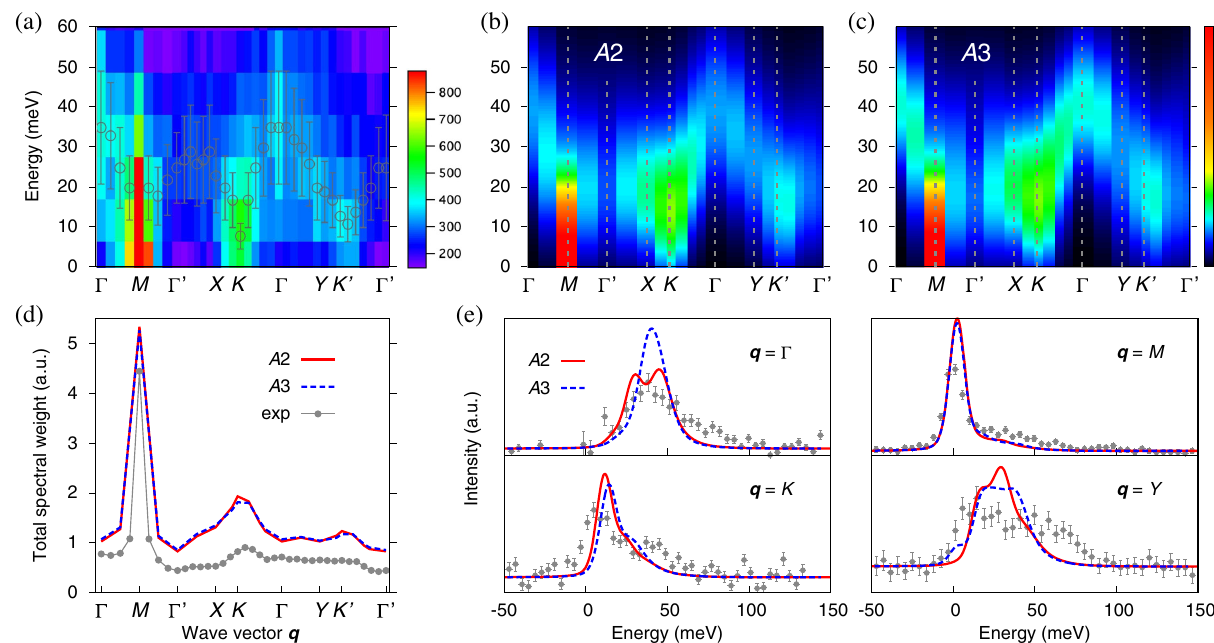
FIG. 4. (a) Experimental RIXS intensity map for T ¼ 7 K with the positions of the intensity maxima for the individual wave vectors indicated as open circles. (b) Theoretical RIXS intensity map calculated for the parameter values corresponding to the A 2 point in Fig. 3 and the energy scale A ¼ 29 meV, which gives J ≈ 12 meV, K ≈ − 24 meV, Γ ≈ 11 meV, Γ 0 ≈ − 3 meV, J 2 ≈ 1 . 5 meV, and J 3 ≈ 3 meV. The scattering geometry depicted in Fig. 1(a) is assumed, and a sum of π − π 0 and π − σ 0 scattering channels is taken, corresponding to an unpolarized detection. The spectra are broadened in energy by Gaussians with a FWHM of 25 meV to imitate the experimental resolution as in (a). (c) The same as in (b) but for the parameter values corresponding to the A 3 point in Fig. 3 and the energy scale of A ¼ 24 meV: J ≈ 10 meV, K ≈ − 15 meV, Γ ≈ 16 meV, Γ 0 ¼ − 2 . 4 meV, J 2 ¼ 1 . 2 meV, and J 3 ¼ 2 . 4 meV. (d) Energy-integrated RIXS response (total spectral weight) corresponding to (a) – (c). The experimental data, obtained by integrating in the ½ − 30 ; 60 (cid:2) meV range, are arbitrarily scaled with respect to theoretical ones. (e) RIXS intensity profiles at selected wave vectors. High-resolution experimental data (gray dots) are compared to theoretical spectra for the above parameters (red and blue lines). The theoretical spectra are broadened by the experimental resolution function of the high-resolution